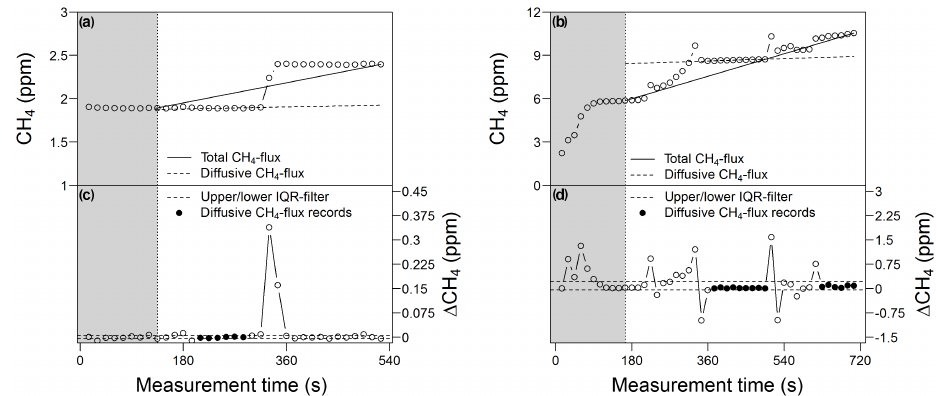
Figure 3. Time series plot of recorded concentrations (ppm) within the chamber headspace for (a) a simulated ebullition event and (b) an exemplary field study CH 4 measurement. Time spans dominated by diffusive CH 4 release are marked by (c, d) black dots, enclosed by the 25 and 75% quantiles ± 0.25 IQR of obtained concentration changes, shown as black dashed lines. Unfilled dots outside the dashed lines display ebullition events (see also Goodrich et al., 2011; Miller and Oremland, 1988). Grey shaded areas indicate the applied death band at the beginning of each measurement (25%). Negative (cid:49) CH 4 values indicate a overcompensation due to (temporally) insufficient headspace